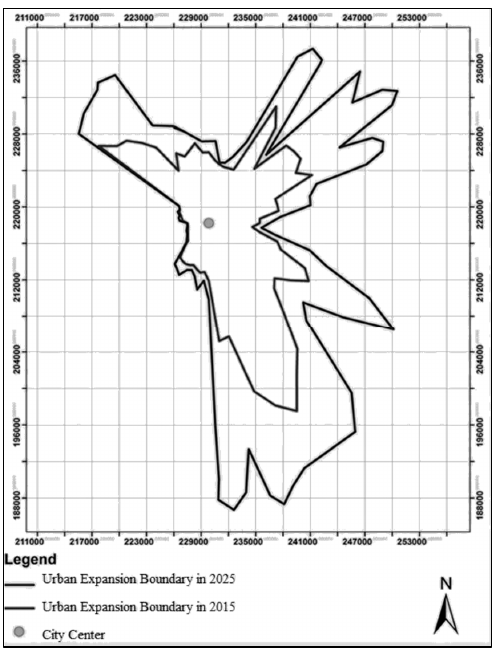
Figure 12. Prediction map for 2025 resulting from the use of TDNN.